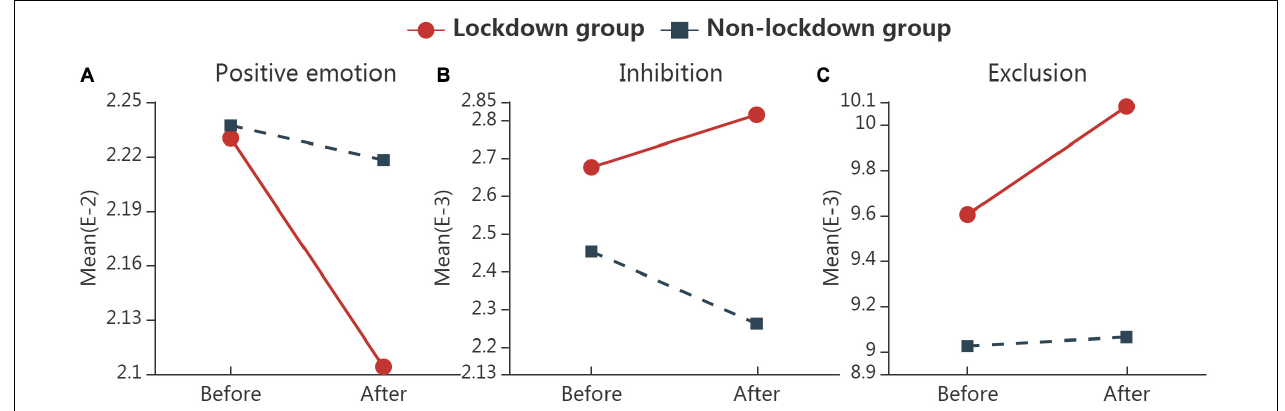
FIGURE 2 | The interaction plots for words with significant interactions in high-endemic subgroup. Significant group (confinement vs. non-confinement) * time (before vs. after confinement) interaction was found in the frequency of positive emotion words (A) , Inhibition words (B) , and Exclusion words (C) by RM ANOVA. “Confinement” represents samples in all 14 cities where home confinement have implemented; “Non-confinement” represents samples that have not experienced home confinement; “Before” represents the data collected from 2 weeks before home confinement, and “After” represents that from 2 weeks after.